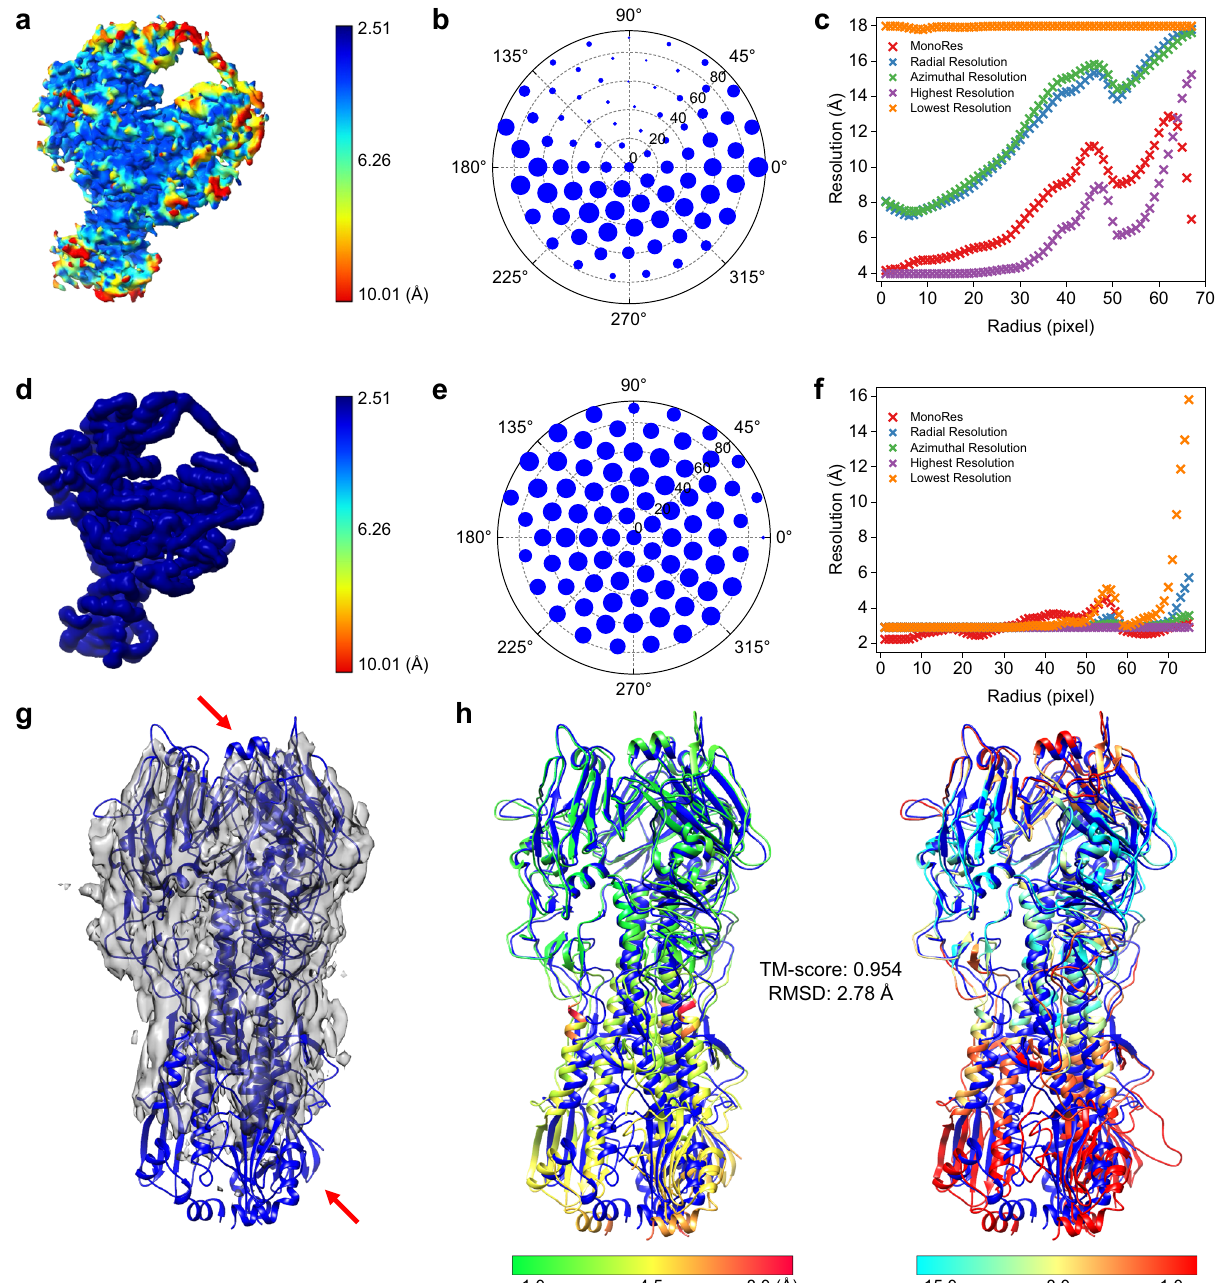
Fig. 8 Model building by EMBuild on an EM map with anisotropy. a – f Comparison of local anisotropy for the EM density map ( a – c ) and the main-chain probability map ( d – f ) of EMD-20501, respectively. a , d Local resolution map. b , e Angular plot of local-directional resolution map. c , f Radial average of local-directional resolution map. g , h The EMBuild model built on an untilted reconstruction of In fl uenza hemagglutinin (HA) trimer (EMPIAR-10096) that has severe anisotropy in the map. g The reference PDB model (PDB ID: 7VDF) colored in blue superimposed onto the EM map colored in transparent gray. Red arrows indicate the regions with missing density. h Comparison between C α displacements and main-chain match scores of the EMBuild model. The EMBuild model is colored by C α displacements to the deposited PDB structure (left) and is colored by main-chain match scores (right). The reference deposited PDB structure is colored in